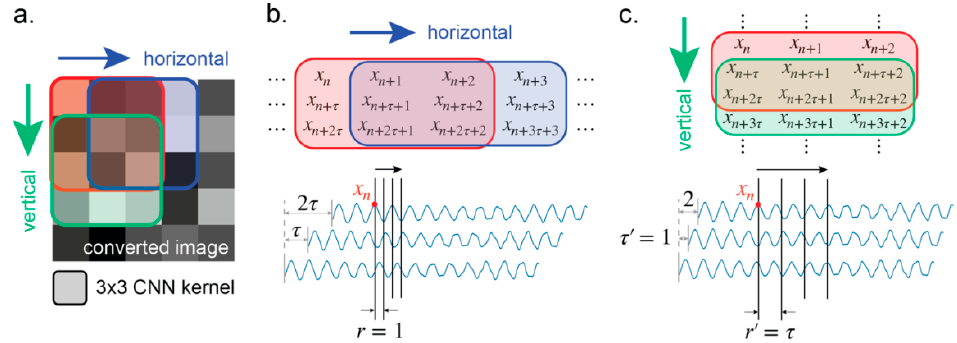
Figure 10. ( a ) Two of the possible interpretations by the CNN of the image: horizontally and vertically. ( b ) With the horizontal interpretation, the parameters of the reconstruction are the same as in the proposed method. ( c ) The vertical interpretation is equivalent to using an alternative sample rate of τ and delay time of